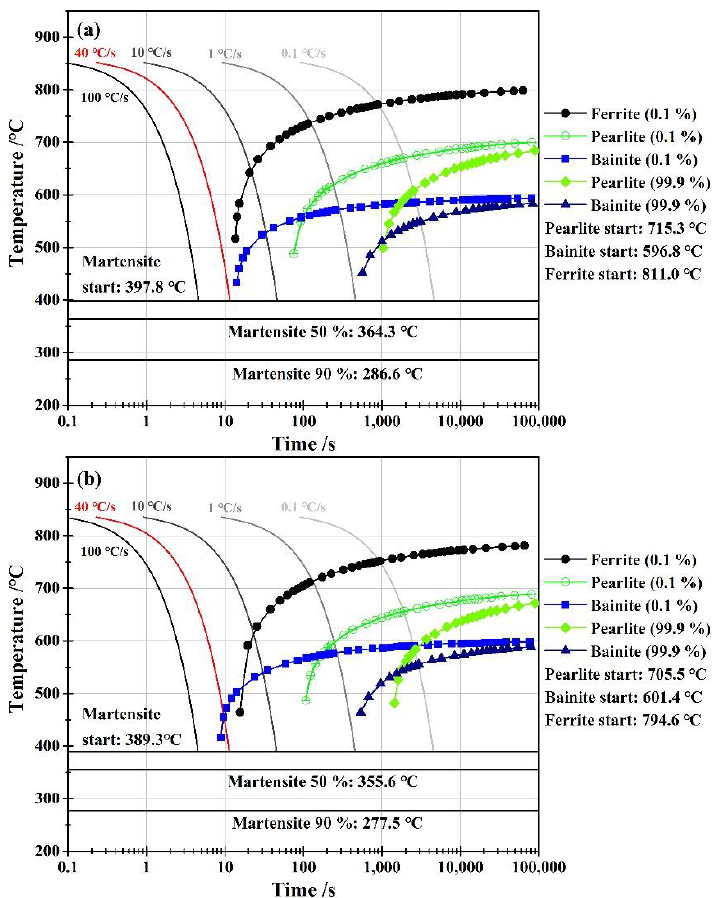
Figure 4. CCT curves of 22MnB5NbV and 22MnB5 steel: ( a ) 22MnB5NbV; ( b )